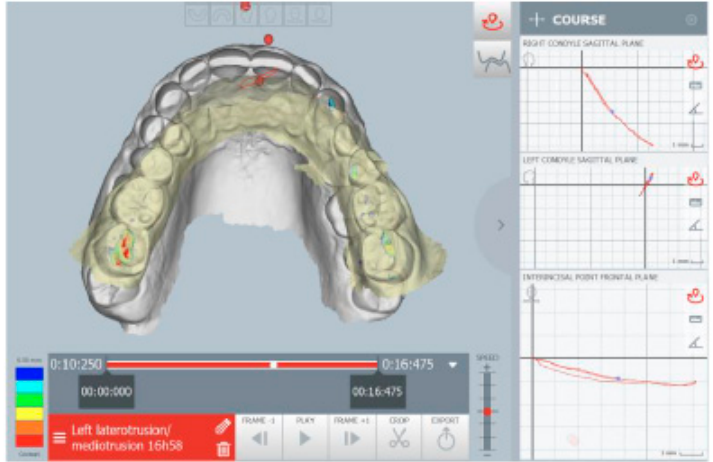
Figure 6. Left lateral movement.